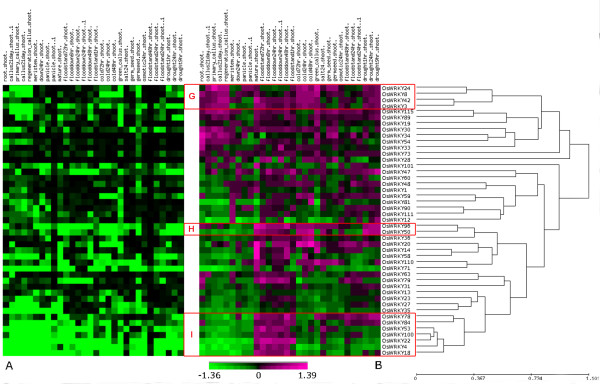
Clustering of OsWRKY genes according to their expression profile in the NIAS 22 K array. Clustering of the 50 OsWRKY genes present in the NIAS 22 K array according to their expression profiles in 30 experiments (upon abiotic stress conditions and in different plant tissues) was performed. Panel A T-test P-values (shown by a green - black gradient) of treated vs control of the corresponding ratios shown in Panel B. The range of log transformed P-values comprised values between 0.01 (green) and 1 (black). P-values lower than 0.01 were visualized as 0.01. Panel B log2(Treated/Control) ratio values (shown by a green - magenta gradient). Red boxes with capital letters from G to I highlight the presence of co-expressed WRKY gene clusters.